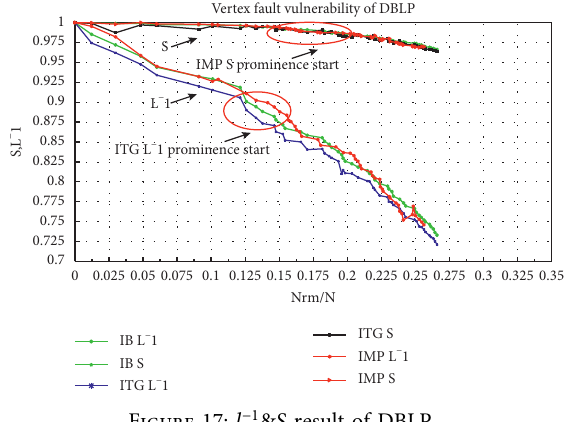
Figure 20: l − 1 & C G �( V,E ) result of Facebook ( X -axis logarithmic coordinate).